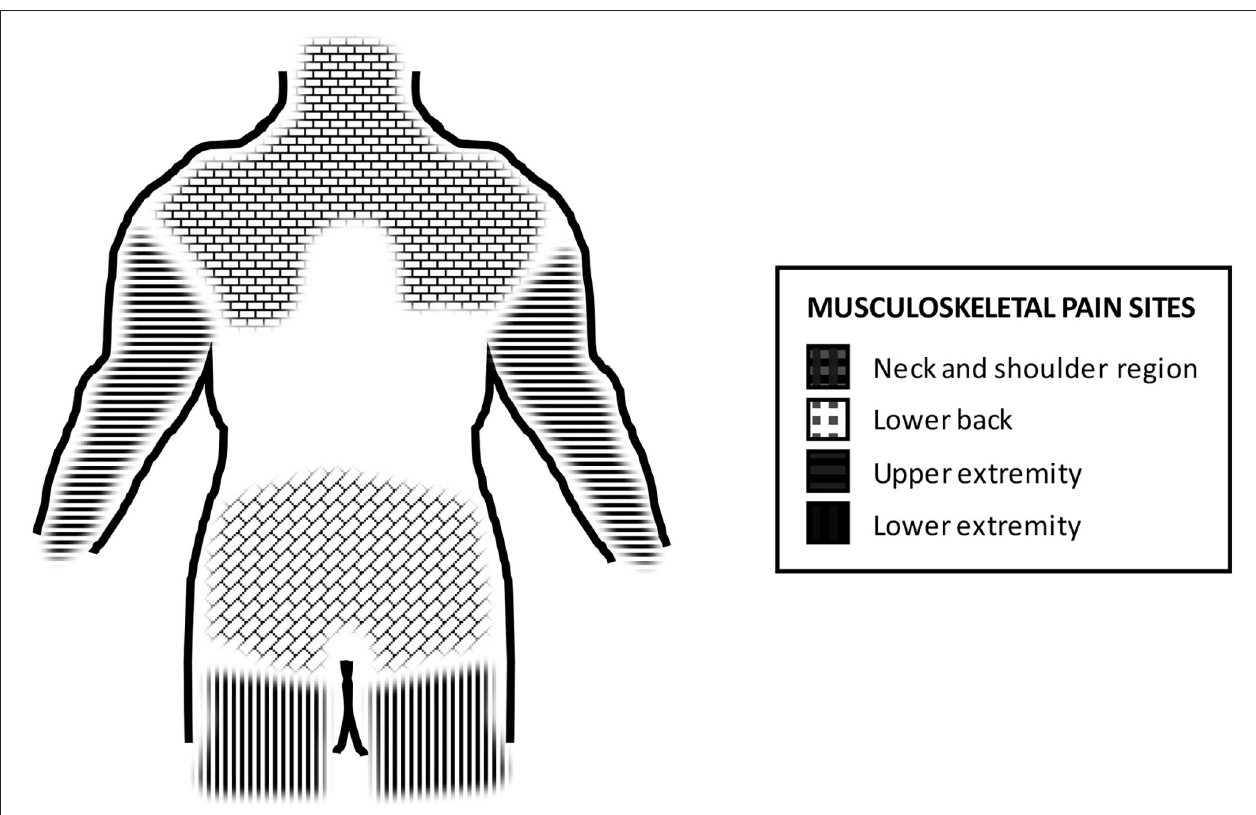
FIGURE 2 | Schematic illustration of the four major musculoskeletal pain